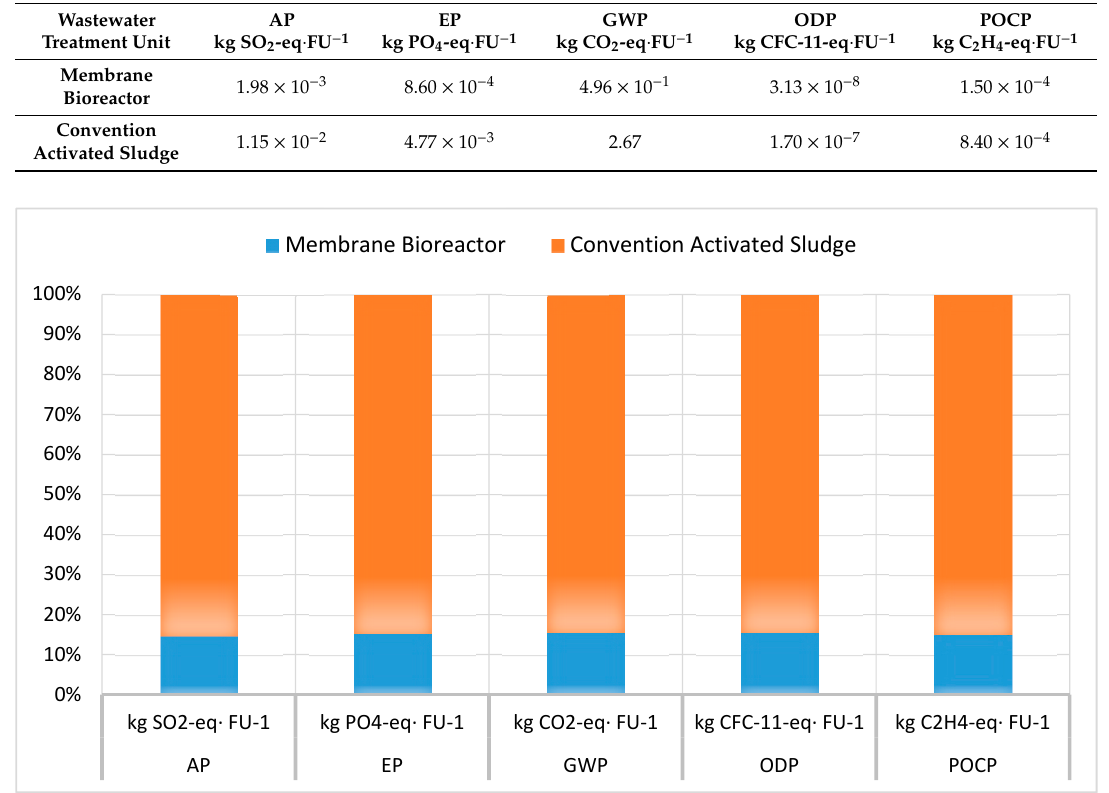
Figure 5. Comparison of the LCIA for the two units with no plant contribution.